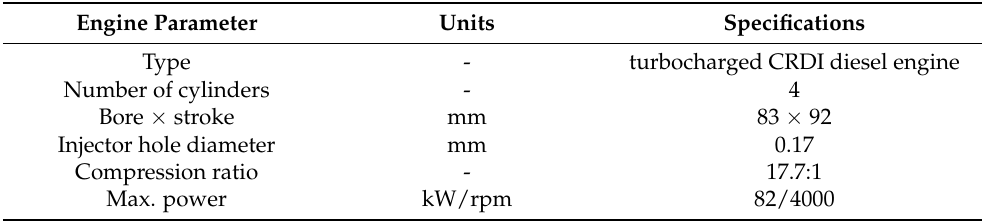
Figure 1. Schematic of experimental setup. Table 2. Specification of test engine.